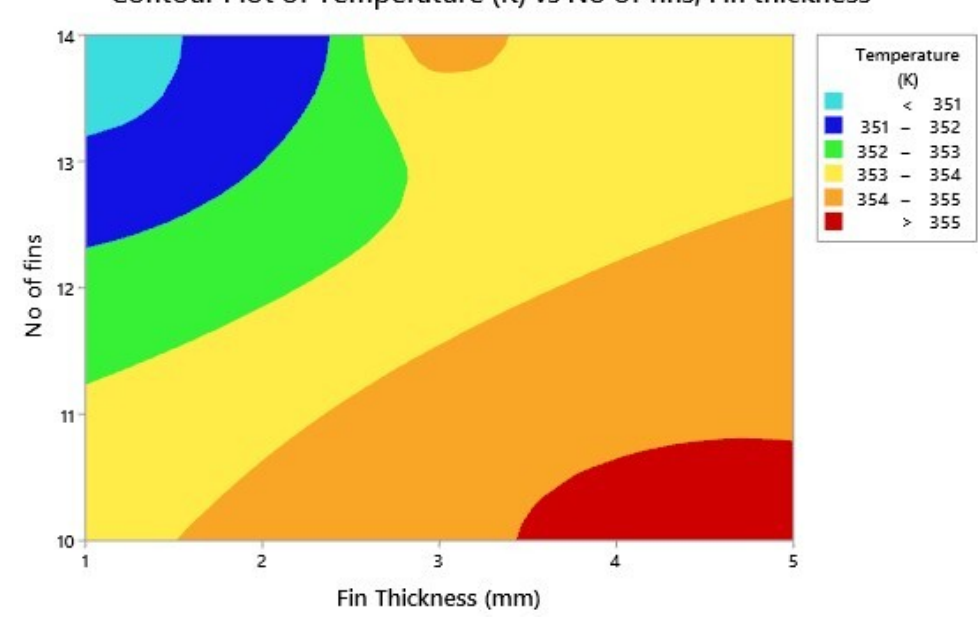
Figure 9. Contour Plot of Temperature vs. No of fins, Fin thickness.